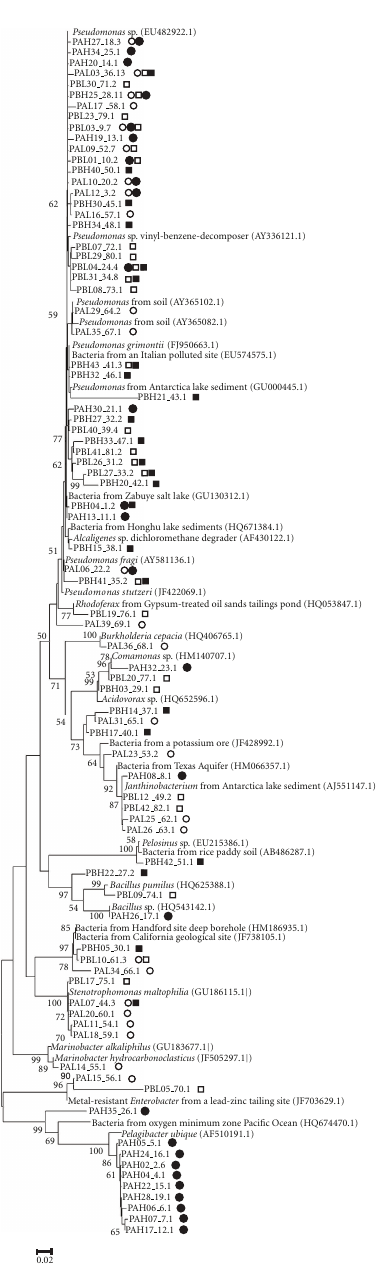
Figure 2: Phylogenetic tree of the 16S rRNA gene-based libraries obtained from platforms A and B. OTUs were defined by MOTHUR using the furthest neighbor algorithm with a distance level of 3%. One representative clone of each OTU (81 OTUs) was used for phylogenetic analysis. Reference sequences from GenBank are highlighted in bold. The tree was constructed based on the neighbor-joining method. Bootstrap analyses were performed with 1,000 repetitions and only values higher than 50% are shown. The scale bar indicates the distance in substitutions per nucleotide. Clones indicated with prefixes PAH and PAL originated from platform A with high- and low-water content, respectively. Clones PBH and PBL were obtained from platform B with high- and low-water content, respectively. The access name of each sequence is formed by numbers that correspond to the following: a representative clone number, followed by the OTU and the number of clones in that OTU (e.g., sequence PAH27 18, 3 = name of the clone OTU, number of clones grouped in this OTU). The symbols after each ), PAL ( (cid:4) ), PBH ( ), and/or PBL ( access name indicate that the OTU was found in oil samples from PAH ( (cid:0) (cid:2) (cid:0)